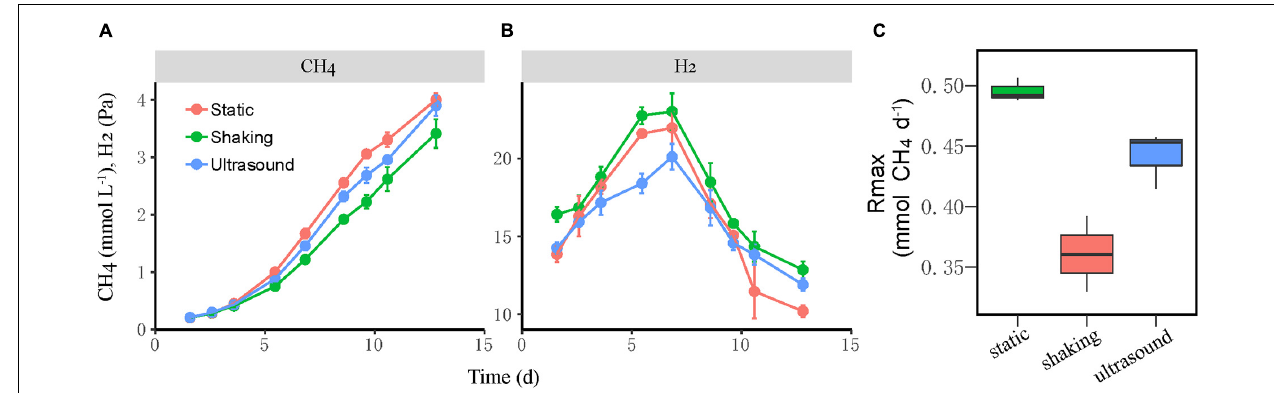
FIGURE 4 | Test for the influence of physical disturbance on the activity of the mesophilic Syntrophomonas – Methanococcus coculture. The actively growing coculture was inoculated to fresh medium, and two disturbance treatments, i.e., intermittent ultrasound and constant shaking, were applied with the static incubation served as the control. Shown are the production of CH 4 (A) and H 2 (B) from butyrate oxidation in three parallel incubations. The maximal rate of CH 4 production (C) was calculated during the period of linear increase of CH 4 concentration. The error bars indicate the standard deviation of four replicates.